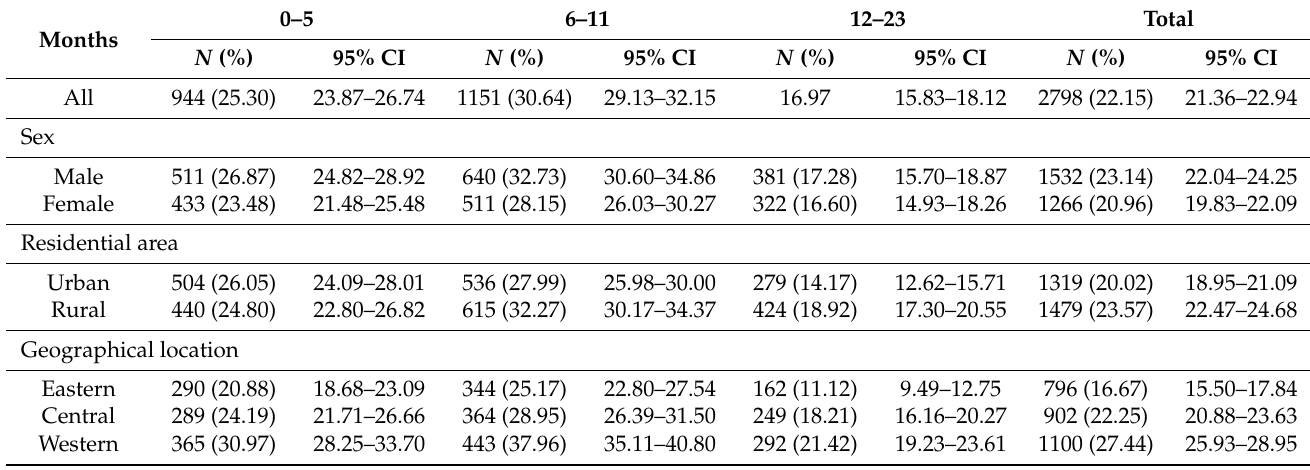
Table 3. Anaemia status of infants stratified by sex, residential area and geographical